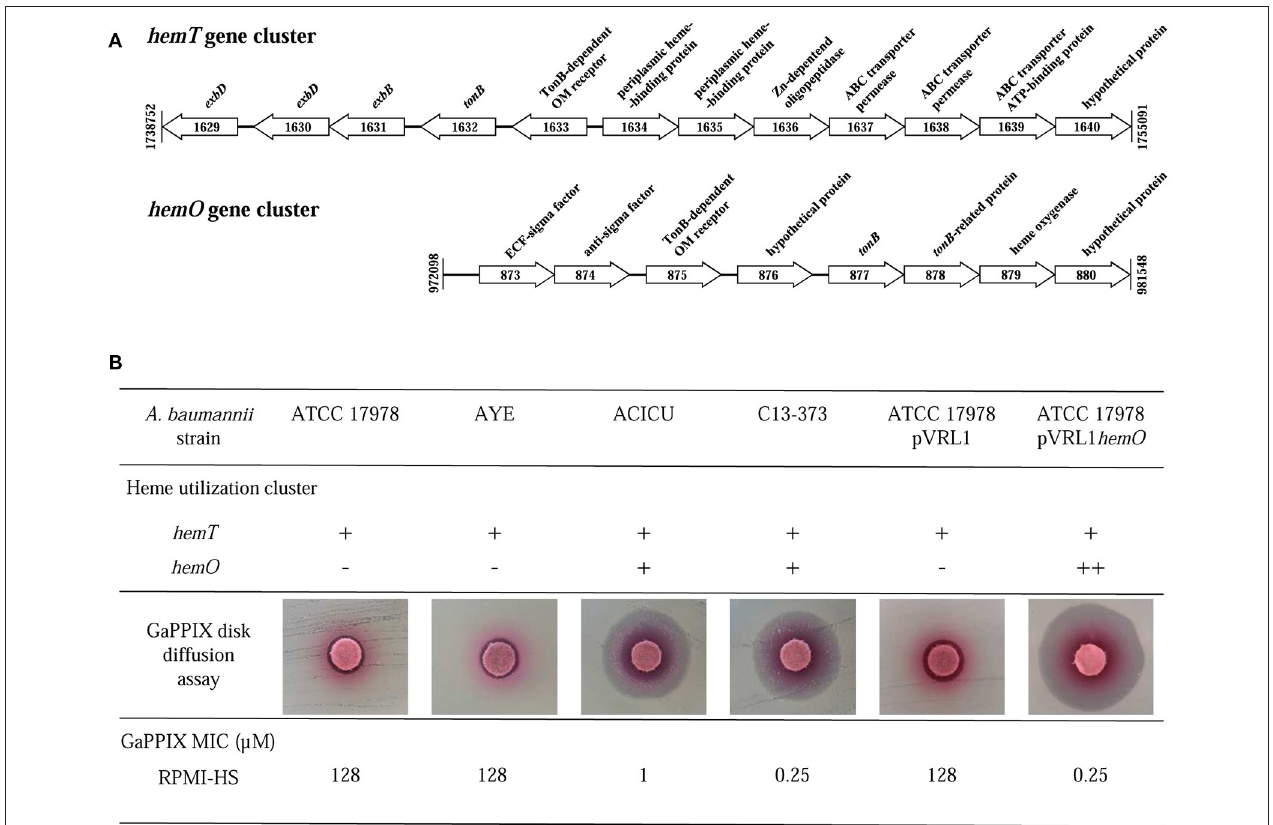
FIGURE 4 | Influence of heme-uptake systems on A. baumannii susceptibility to GaPPIX. (A) Schematic representation of the two gene clusters for heme uptake, hemT and hemO, of A. baumannii ACICU. Coding sequences are shown as arrows (not to scale) oriented according to the predicted direction of transcription. (B) Top; presence ( + ) or absence (-) of heme clusters in different A. baumannii strains ( ++ , overexpression from the multicopy plasmid pVRL1 hemO ). Middle; GaPPIX disk diffusion assay in RPMI-HS agar plates inoculated with different A. baumannii strains. Bottom; MICs of GaPPIX for different A. baumannii strains in RPMI-HS.